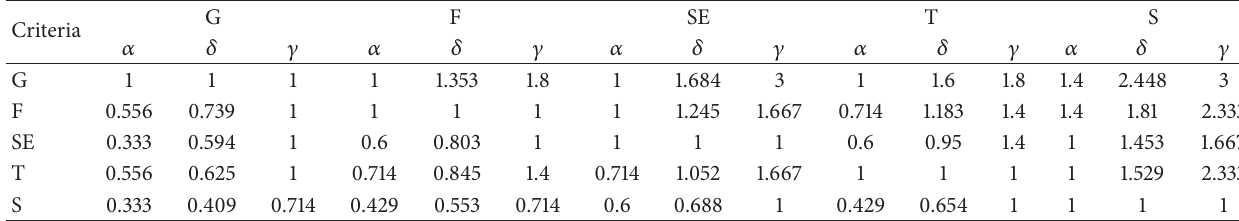
Table 8: Fuzzy Delphi paired comparison matrix for decision makers.